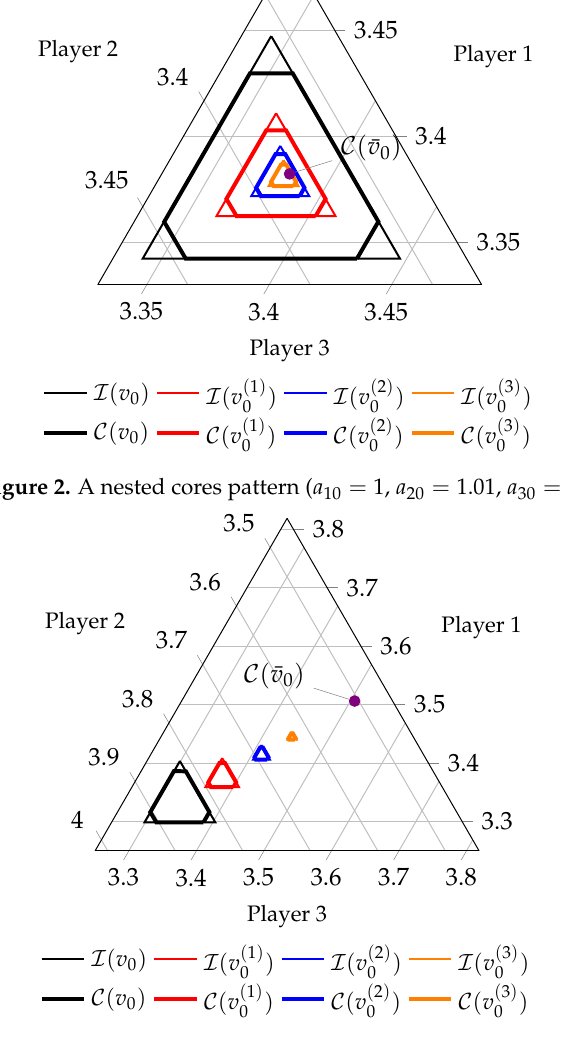
Figure 3. All cores are pairwise disjoint ( a 10 = 1, a 20 = 1.3, a 30 =